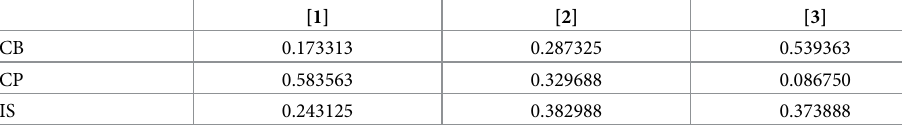
Table 7. Rank probabilities of fixation methods for Lachman’s test.